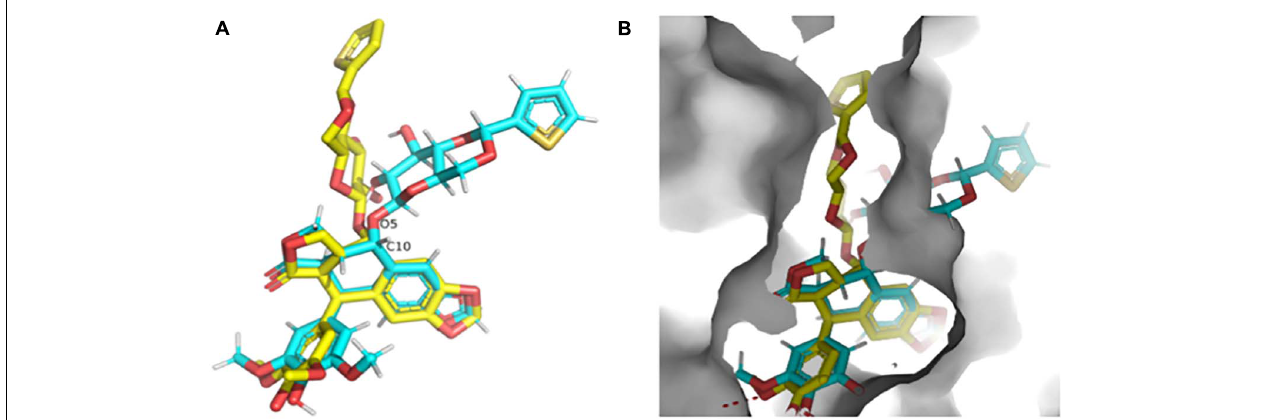
FIGURE 8 | (A) Overlay of the teniposide MicroED structure determined in this paper (cyan carbon atoms, CCDC KUXJUL) and the structure of teniposide bound to human serum albumin (HSA) from PDB 4L9Q (yellow carbon atoms). (B) Overlay of the two teniposide molecules (same coloring scheme as in panel (A) within the HSA binding pocket demonstrating that the conformation observed in solid state form is distinct from the conformation required for protein binding. UCSF Chimera was used to generate these images (Pettersen et al.,